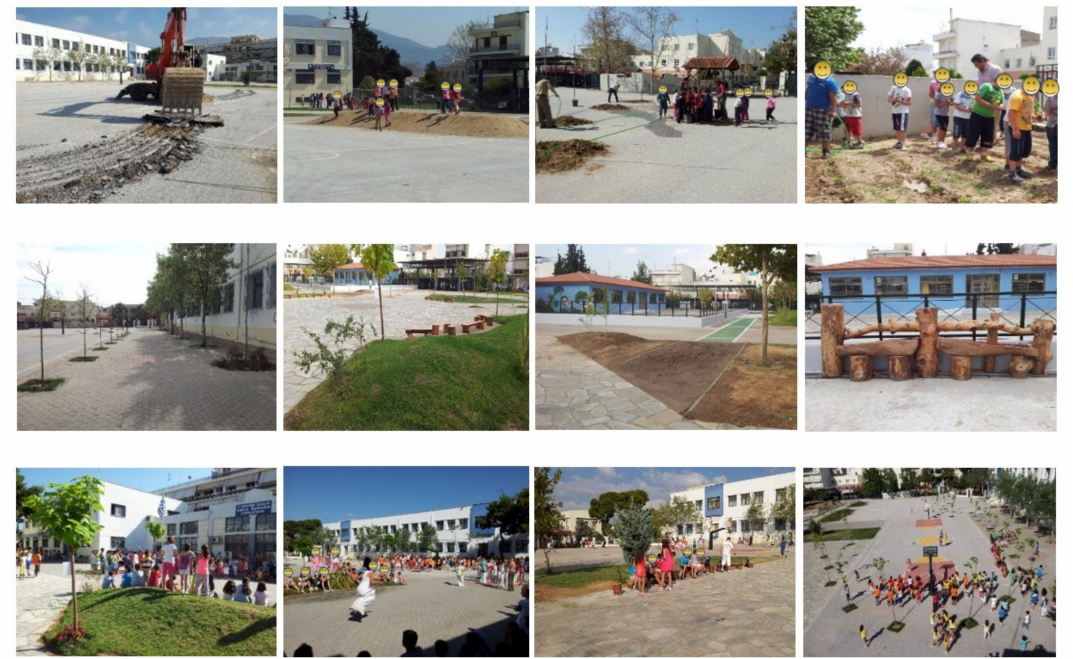
Figure 5. Implementation of the redesign proposal of [7] in an urban schoolyard in Volos, Greece, with the participation of students and the school community. A total of 75 shade trees were planted, 3 amphitheatrical mounds planted with turf, 400 m 2 of new area planted with turf were introduced and wooden configurations together with playing facilities were